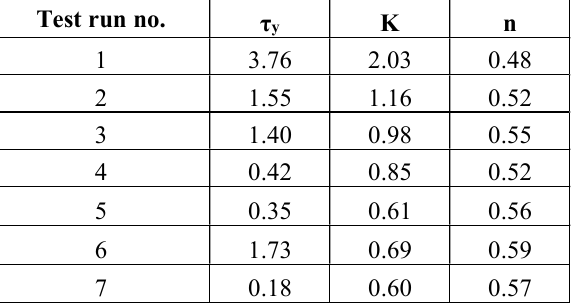
Tabl e 1 . Rheological properties of CBP solutions .